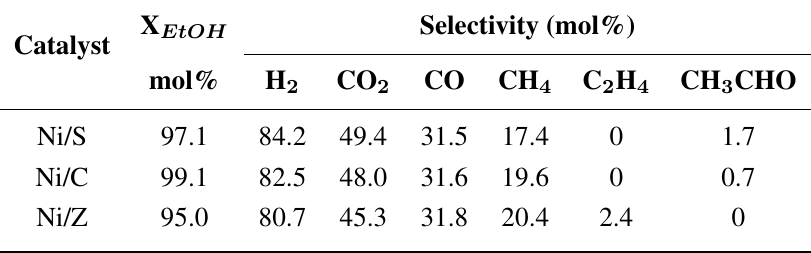
Results of ethanol steam reforming obtained with the reference catalysts (atmospheric pressure; T: 600 ◦ C ; weight hourly space velocity; WHSV: 12.7 h − 1